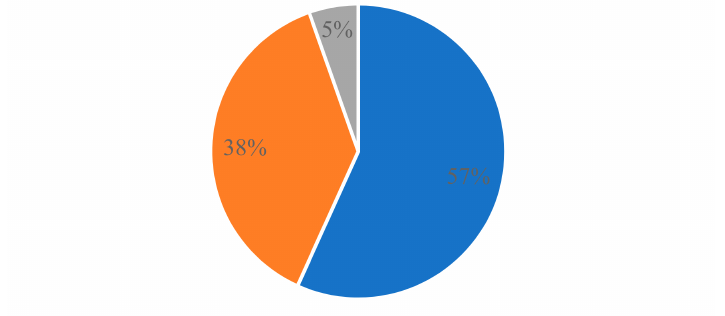
Figure 5. Agri-food